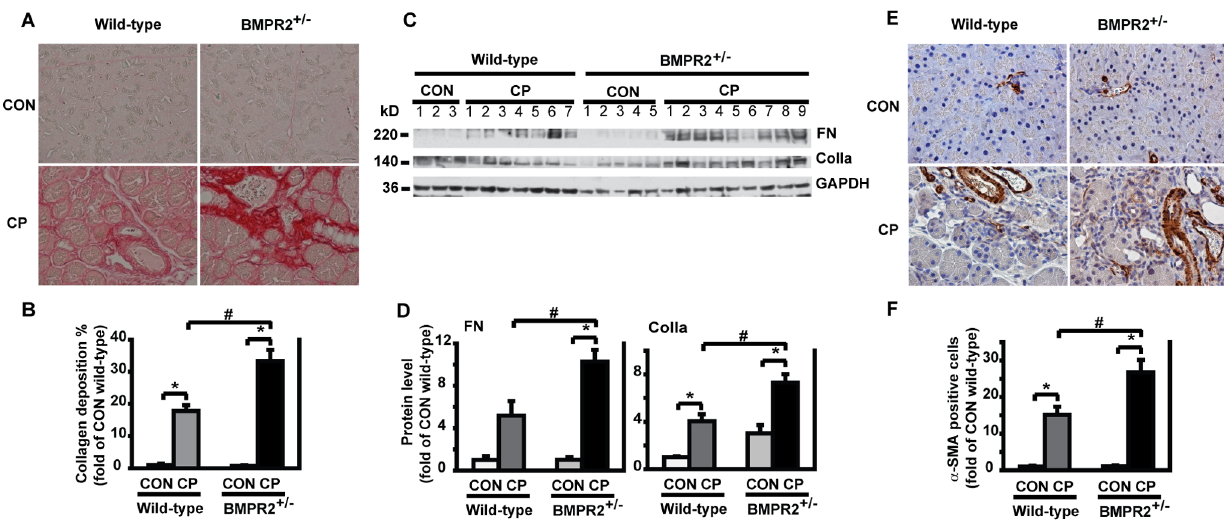
Figure 2. BMPR2 deficiency enhanced pancreatic fibrosis and PSC activation after CP induction. (A) Representative images of sirius red staining for collagen deposition in the pancreas. (B) Quantification of collagen deposition. CON wild-type: n=4, CON BMPR2 + / 2 : n=5, CP wild-type: n=7, CP BMPR2 + / 2 : n=9. Original magnification 6 400. (C) ColIa and FN protein levels in the pancreas by Western blotting. (D) Quantification of ColIa and FN. The protein levels were normalized against GAPDH and quantified as fold of CON wild-type. CON wild-type: n=4, CON BMPR2 + / 2 : n=5, CP wild-type: n=7, CP BMPR2 + / 2 : n=9. * P , 0.05 compared with CON, # P , 0.05 compared with CP wild-type. (E) Representative images of immunohistochemistry against a -SMA on paraffin-embedded pancreatic sections. (F) Quantification of a -SMA-positive cells in the periacinar areas.